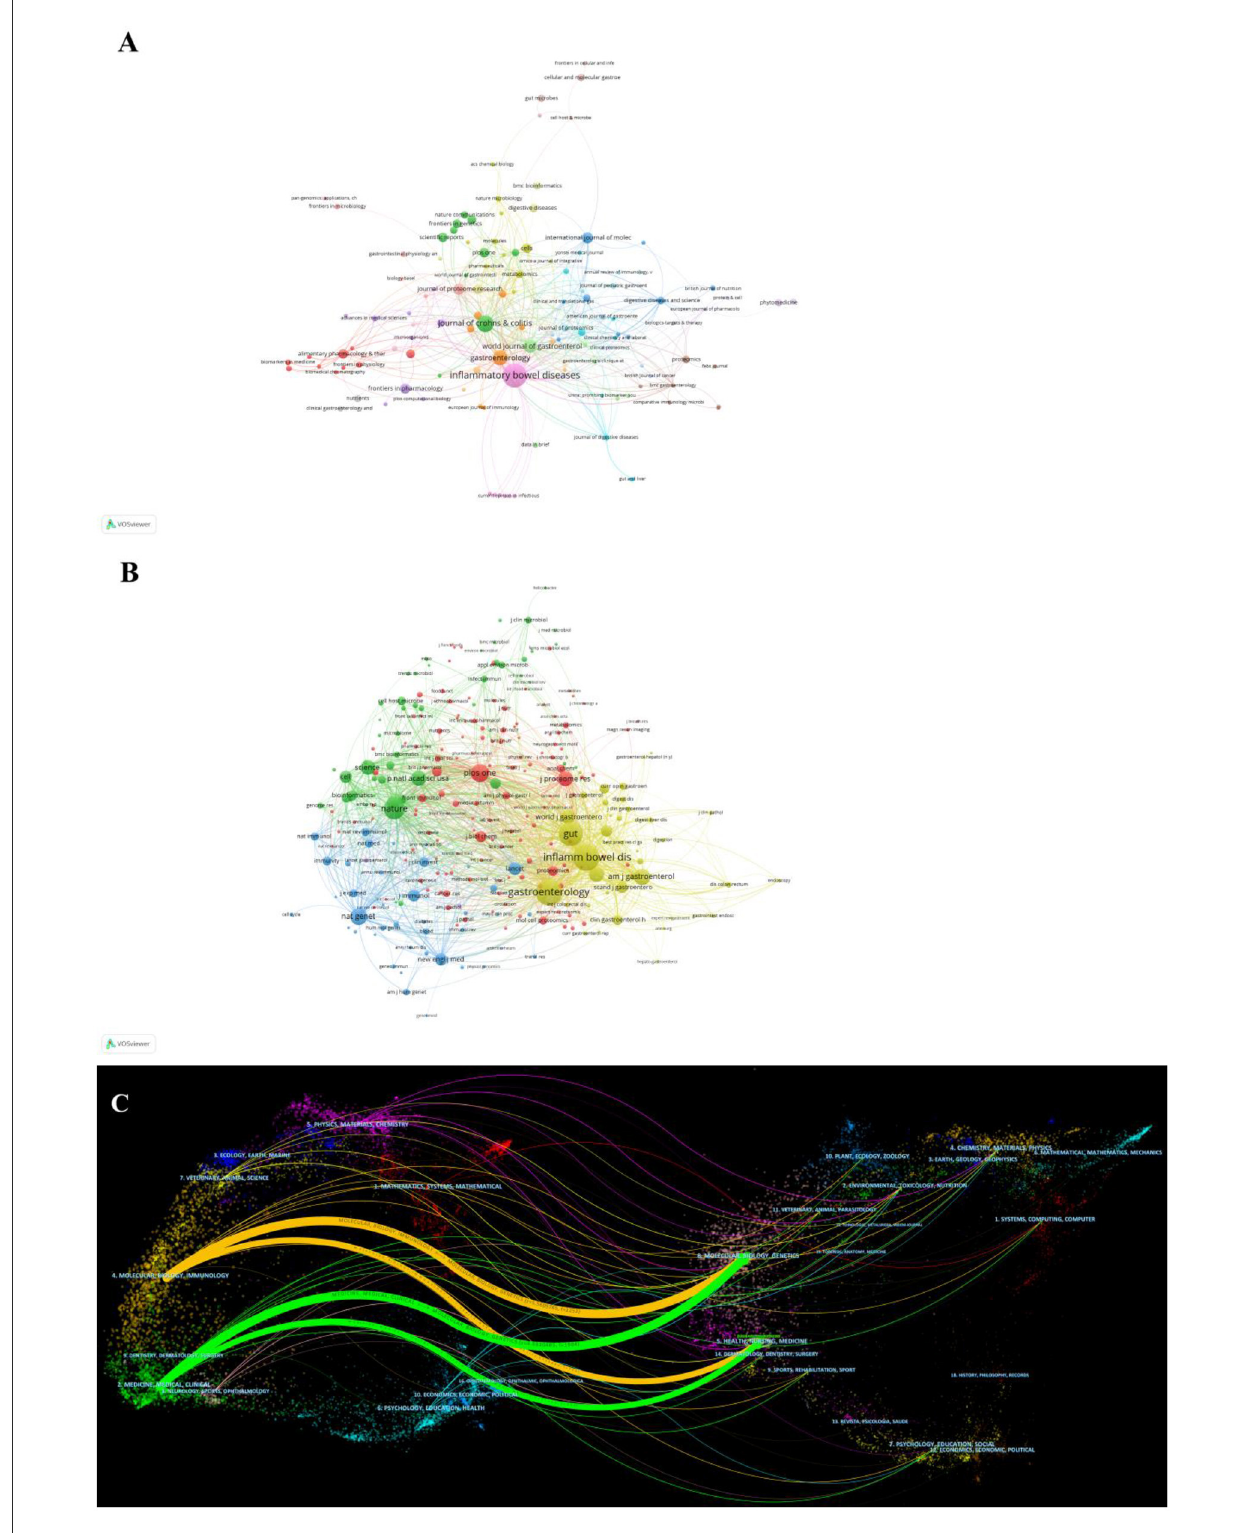
FIGURE5 (A) Network of journals on research of omics in UC. (B) Network of co-cited journals on research of omics in UC. (C) The dual-map overlay of journals on research of omics in